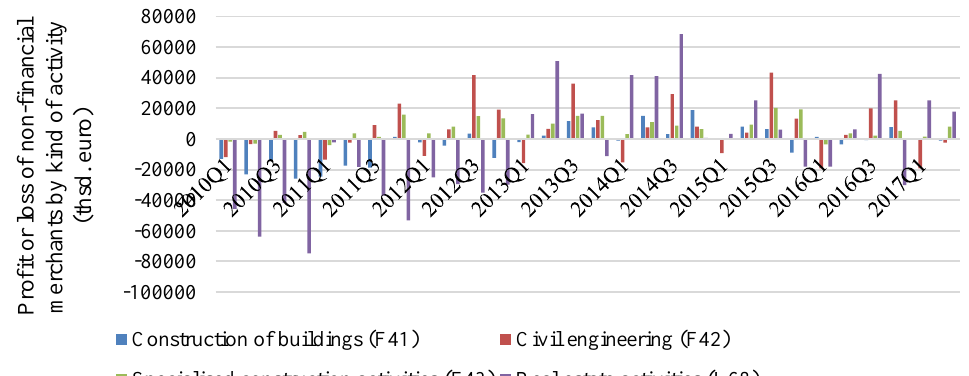
Fig. 3. Profit or loss of merchants (commercial companies) by the kind of activity (NACE Rev.2) (thsd. euro). Data: Central Statistical Bureau of Latvia (n.d.). (Figure made by authors).